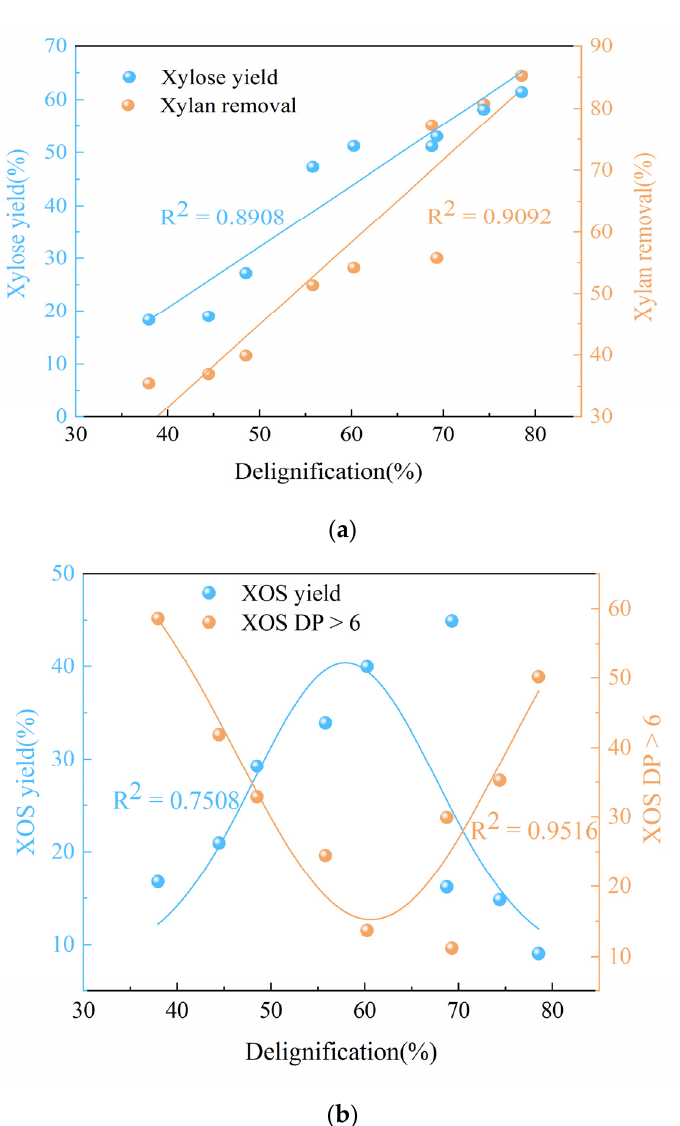
Figure 2. Impact of delignification on xylan removal and xylose yield ( a ). Impact of delignification on XOS yield and XOS DP > 6 yield ( b ).